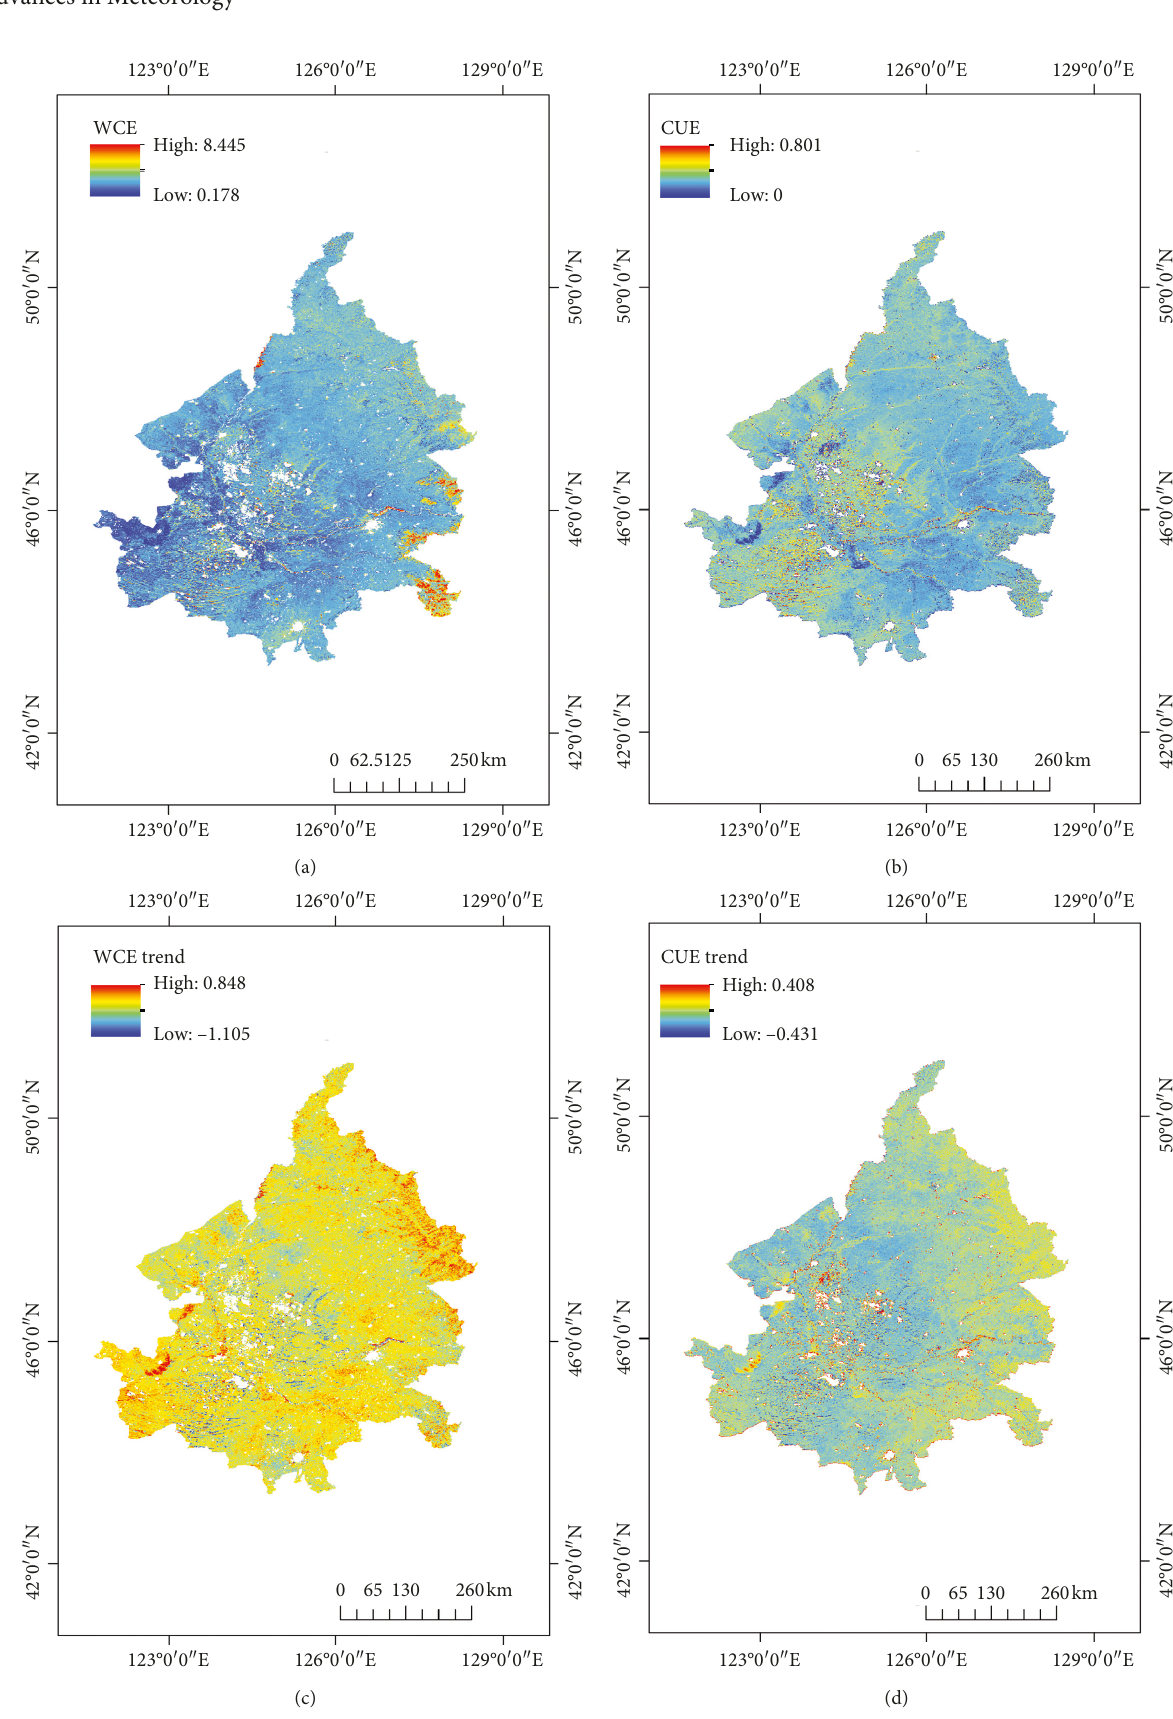
Figure 4: Spatial distribution and trend of WUE and CUE in the SNP (2001–2015). (a) Annual average WUE, (b) annual average CUE, (c) WUE change trend, and (d) CUE change